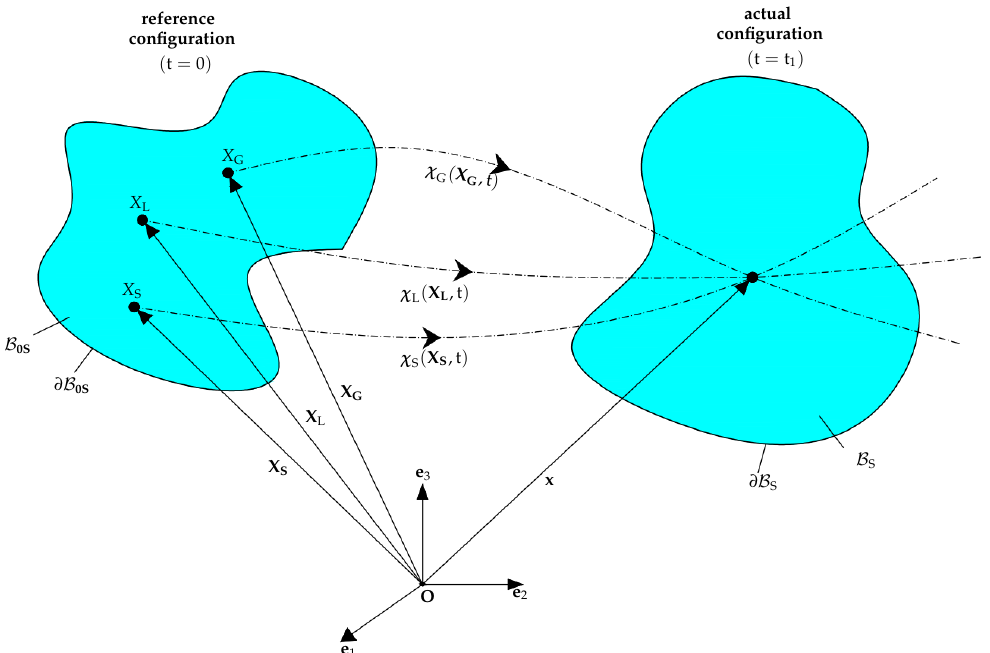
Figure A1. Motion of soil, water, and air particles in the vadose